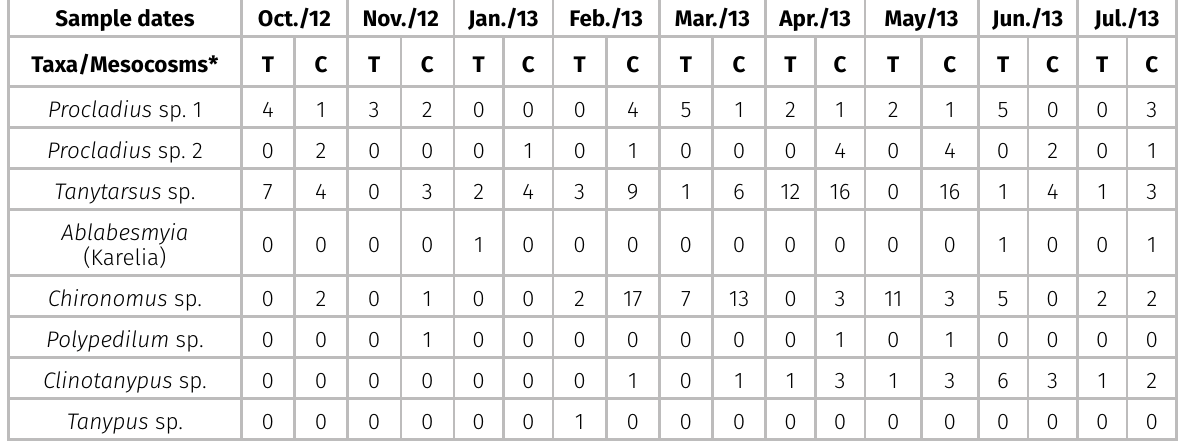
Chironomus sp. Polypedilum